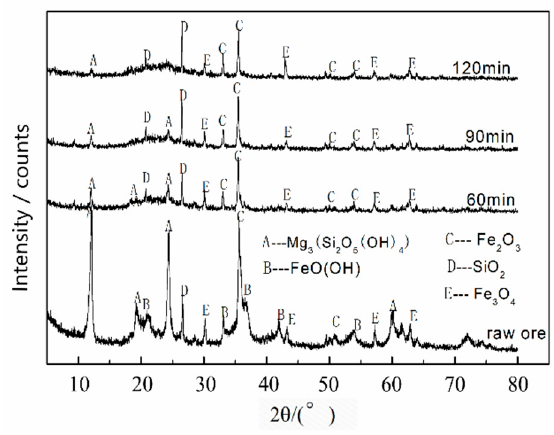
Figure 4. Leaching residues’ XRD diagram at different leaching times.